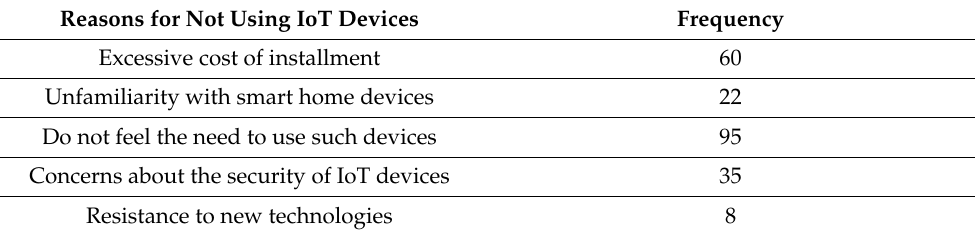
Table 3. Sample of demographics ( n =